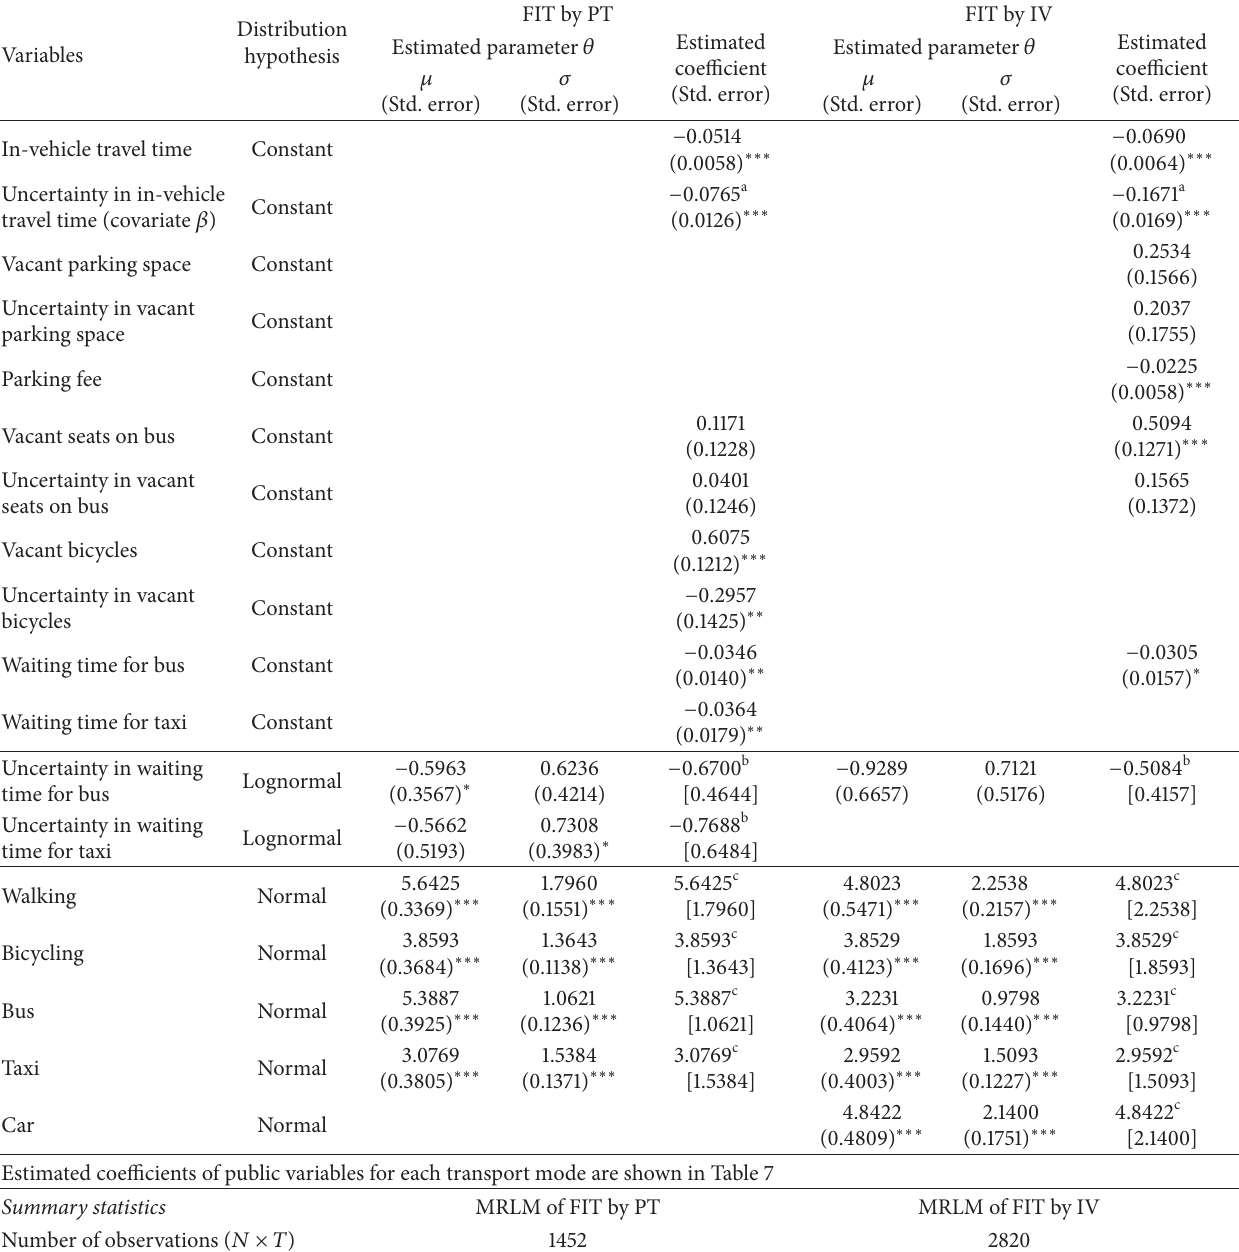
Table 5: Estimated coefficients in Mixed Ranked Logit